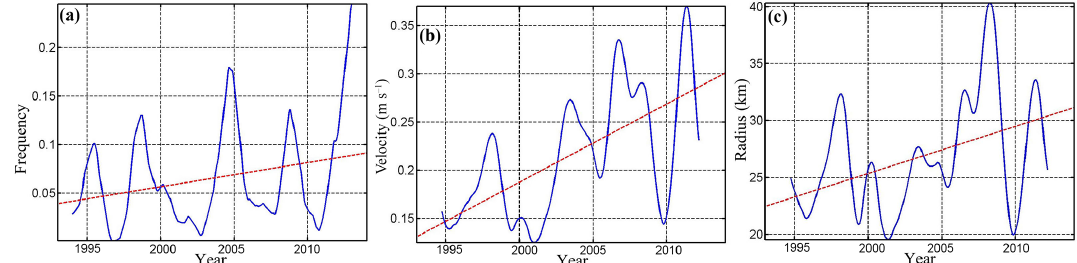
Figure 8. (a) Frequency, (b) maximum orbital velocity, and (c) radius of anticyclones at 38.5 ◦ E, 42 ◦ N, derived from altimetry